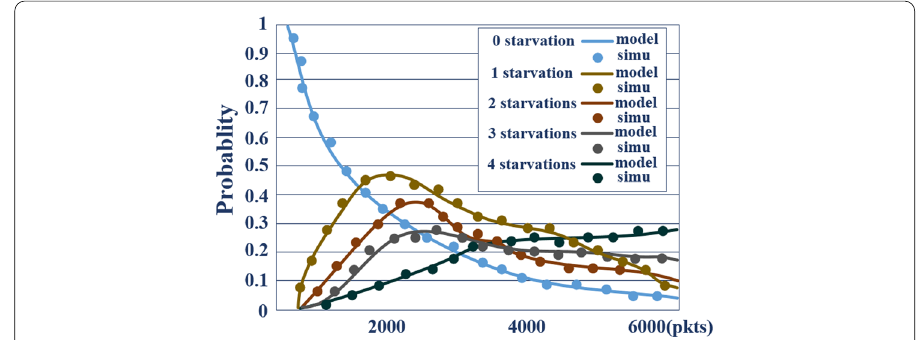
Fig. 5 Probability of 0–4 starvations with